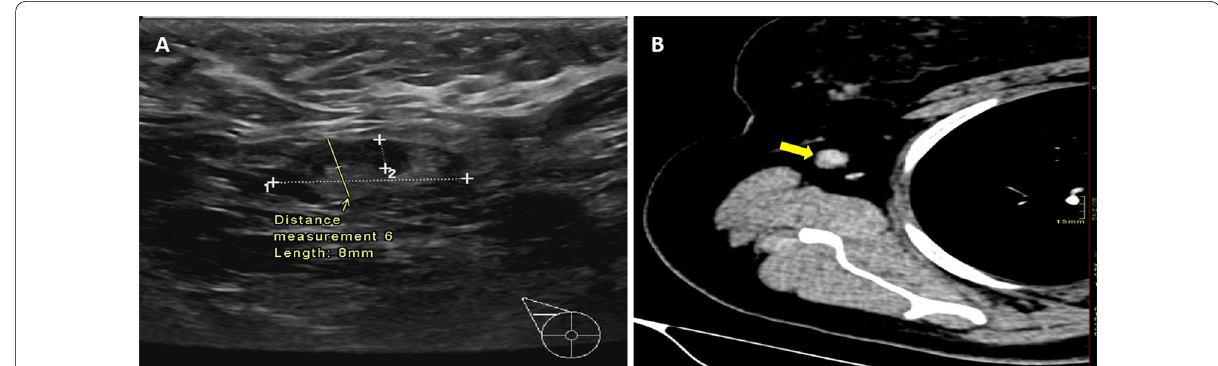
Fig. 2 A 57‑year‑old female with right pathologically proven metastatic axillary lymph node. A Axillary ultrasound image shows indeterminate axillary LN with focal cortical thickness and preserved central fatty hilum (true positive). B CT image shows a pathologically enlarged lymph node with globular shape and eccentric fatty hilum (true positive). LN; Lymph node, CT; computed tomography